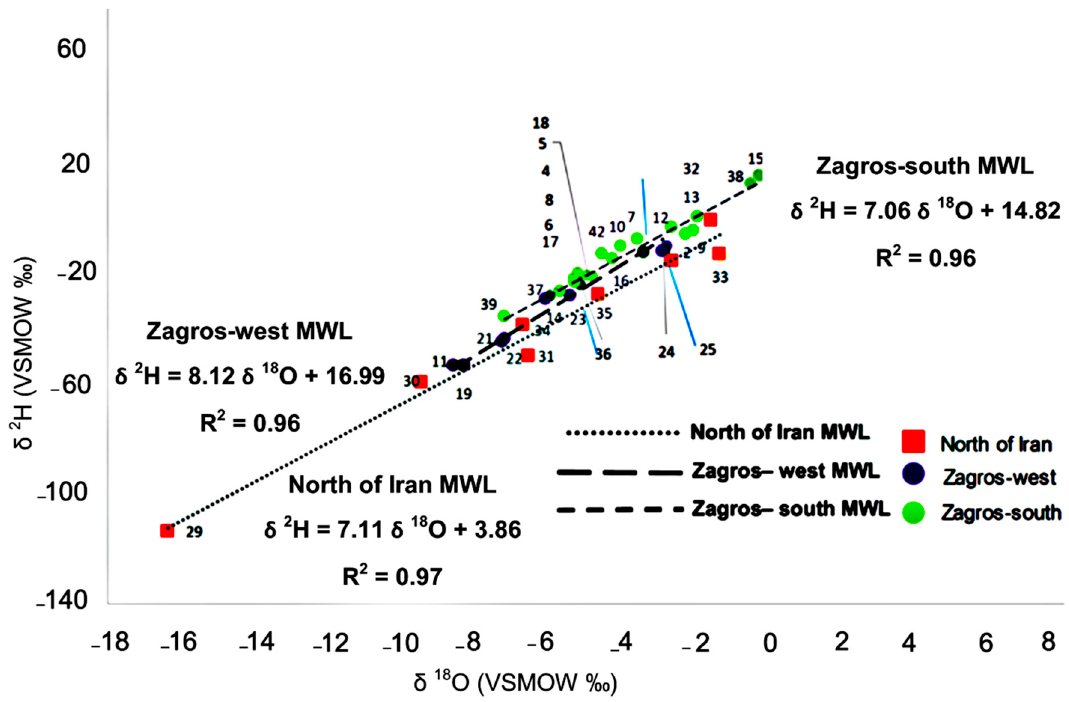
Figure 3. Average δ 2 H and δ 18 O in the sampling station’s precipitation, and Iran developed meteoric water lines (MWLs).